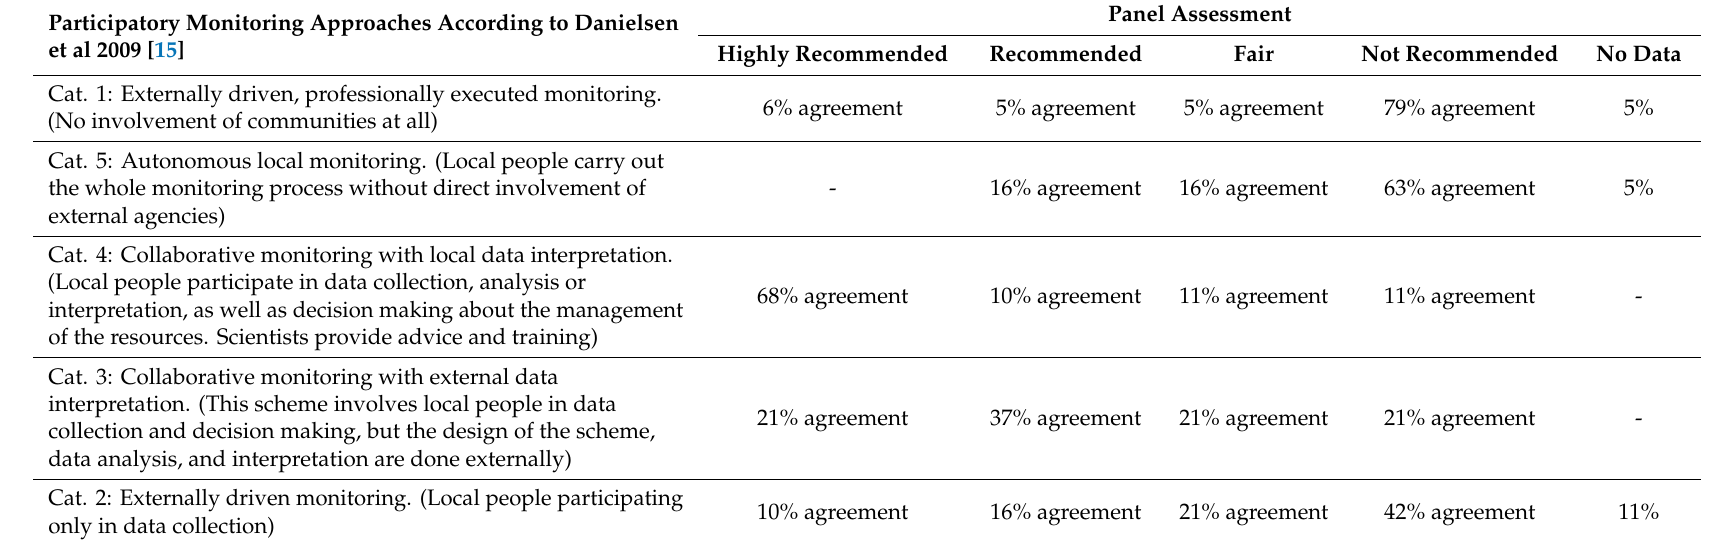
Table A1. First round Delphi panel results on the appropriate monitoring scheme for community-based monitoring of REDD + projects in the